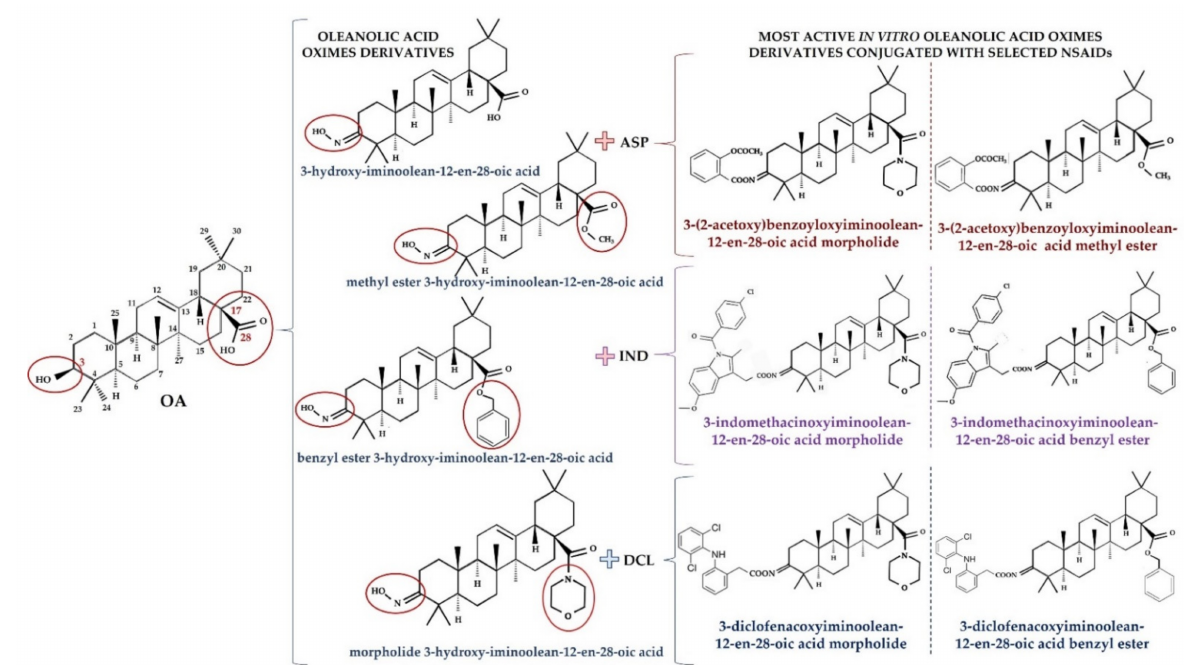
Figure 2. The structures of OAO derivatives and their conjugates with NSAIDs. Figure was created with BioRender.com by the